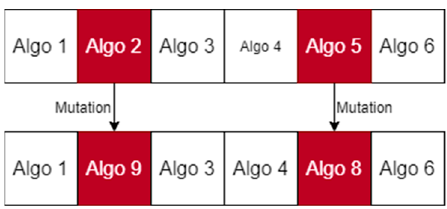
Figure 3. Demonstration of a crossover process.